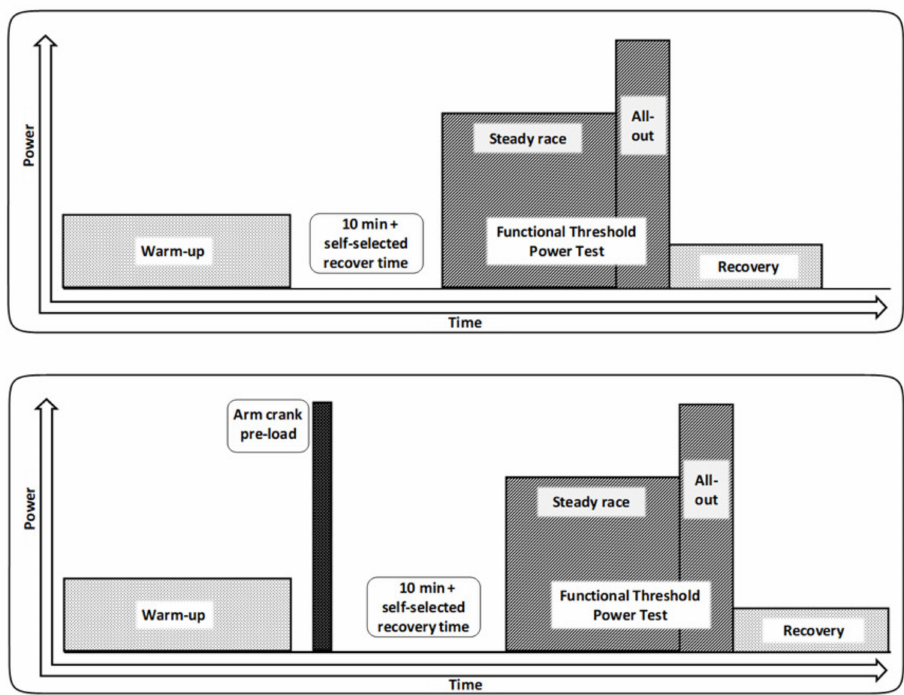
Figure 1. Maximal performance test-low protocol (MPT low ) and high protocol (MPT high